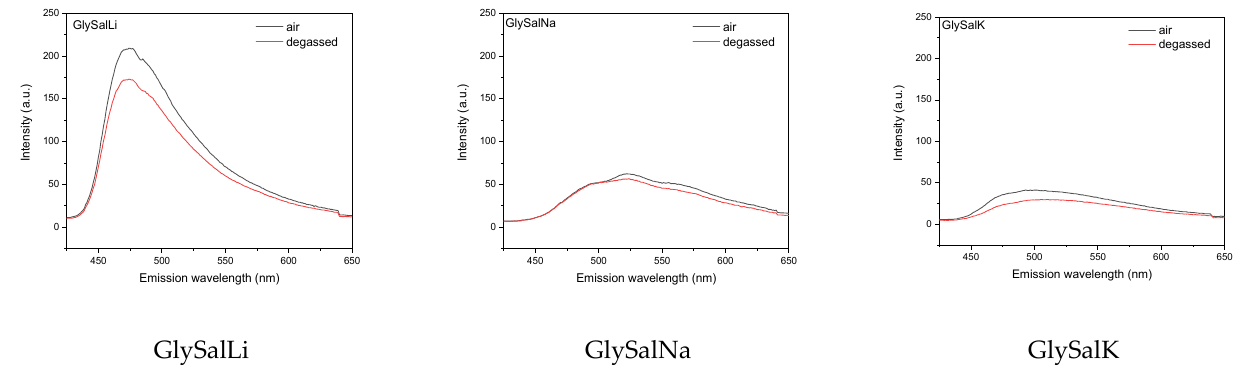
Figure 5. Emission spectra in the solid state of GlySalX in air and after degassing ( λ Ex = 337 nm).